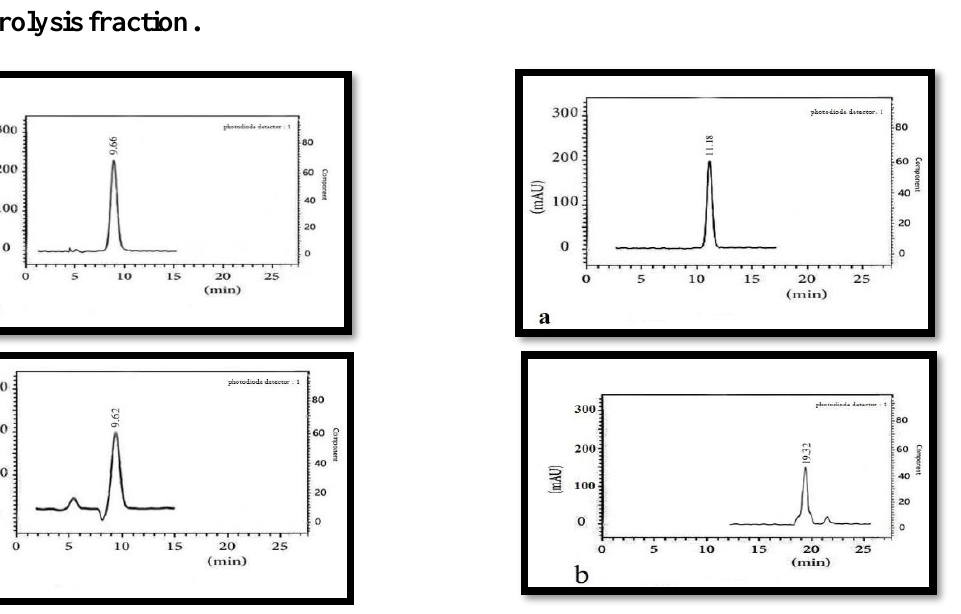
Figure.5. a: HPLC of standard chlorogenic acid, b: HPLC of isolated chlorogenic acid